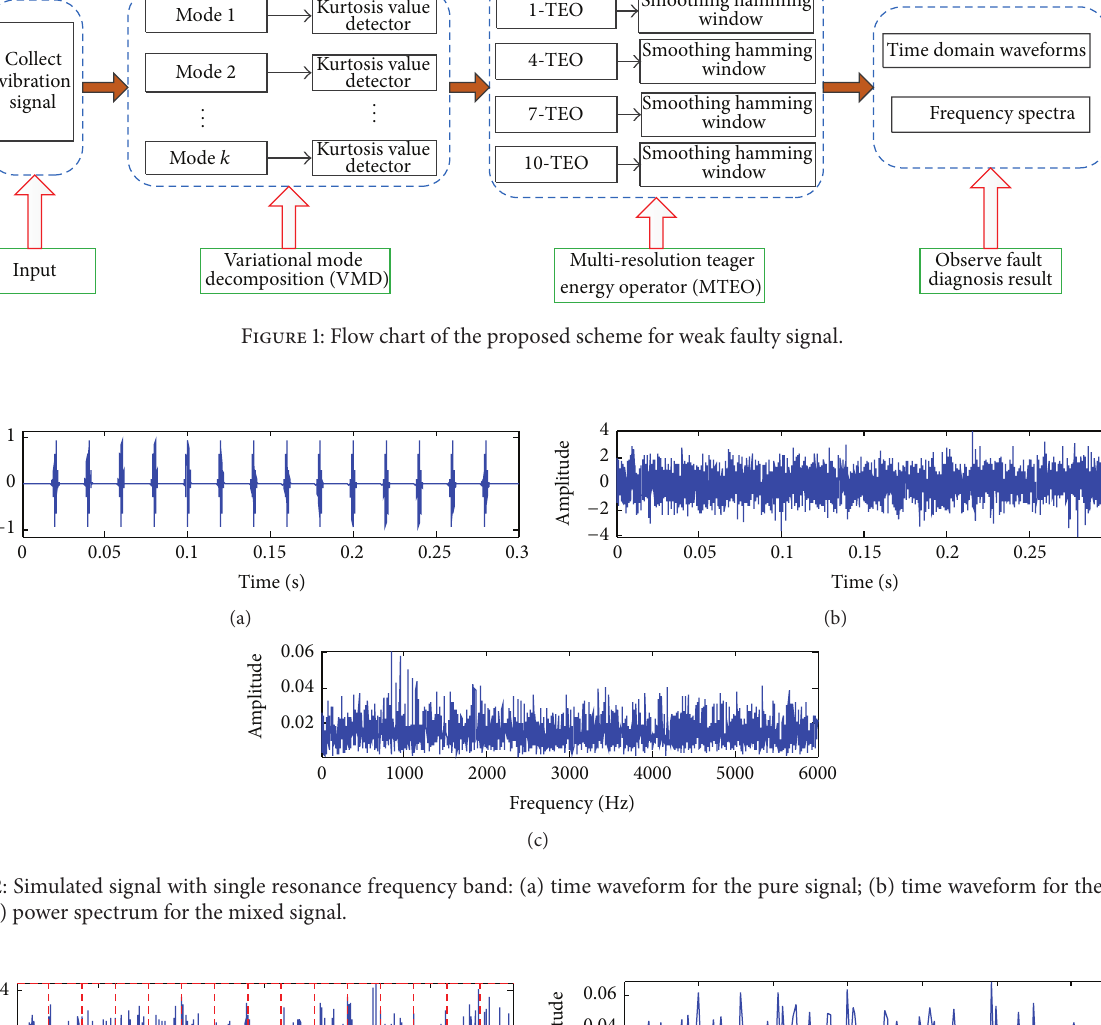
frequency of this faulty signal is 𝑓 𝑑 = 50 Hz. 𝑀 = 14 stands for the number of impulses; 𝑛(𝑡) is the added white